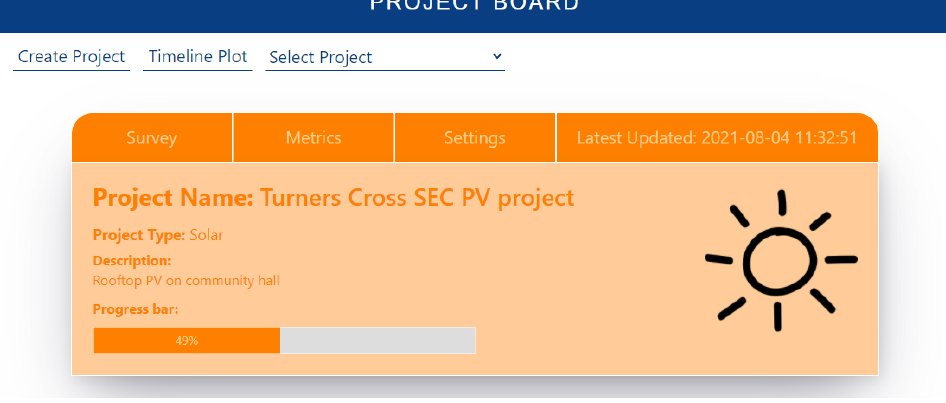
Figure 6. Progress Tool project board.